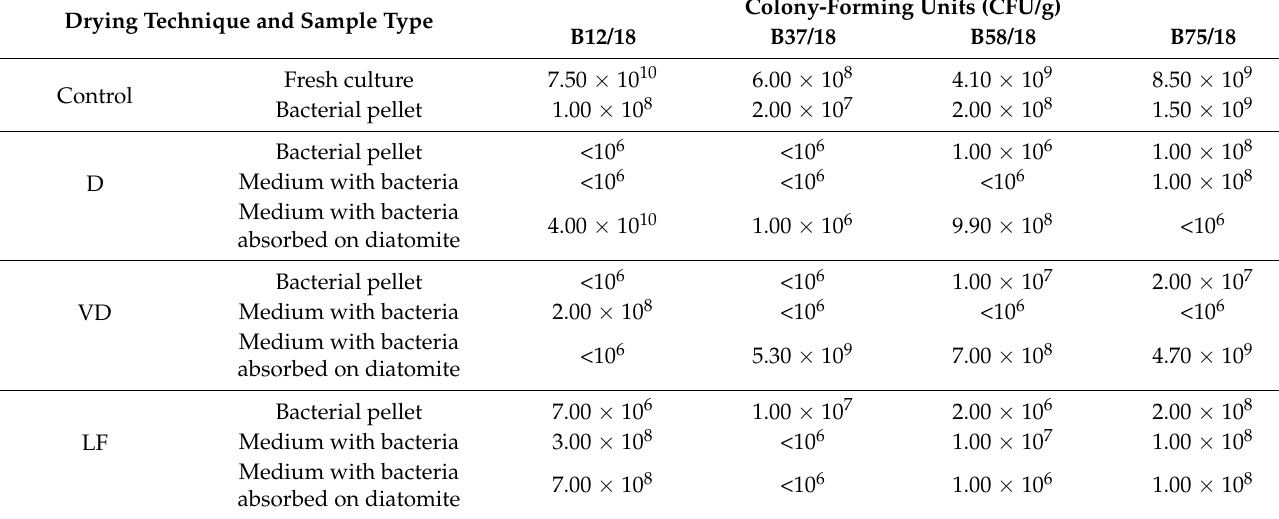
Table 3. The effect of different drying methods and sample preparations on the survivability of bacteria used in naturalization biopreparation. Rhodococcus sp. B12/18, Pseudomonas sp. B37/18, Arthrobacter sp. B58/18, Rhodococcus sp. B75/18, D— drying, VD—vacuum drying, LF—lyophilization. Drying Technique and Sample